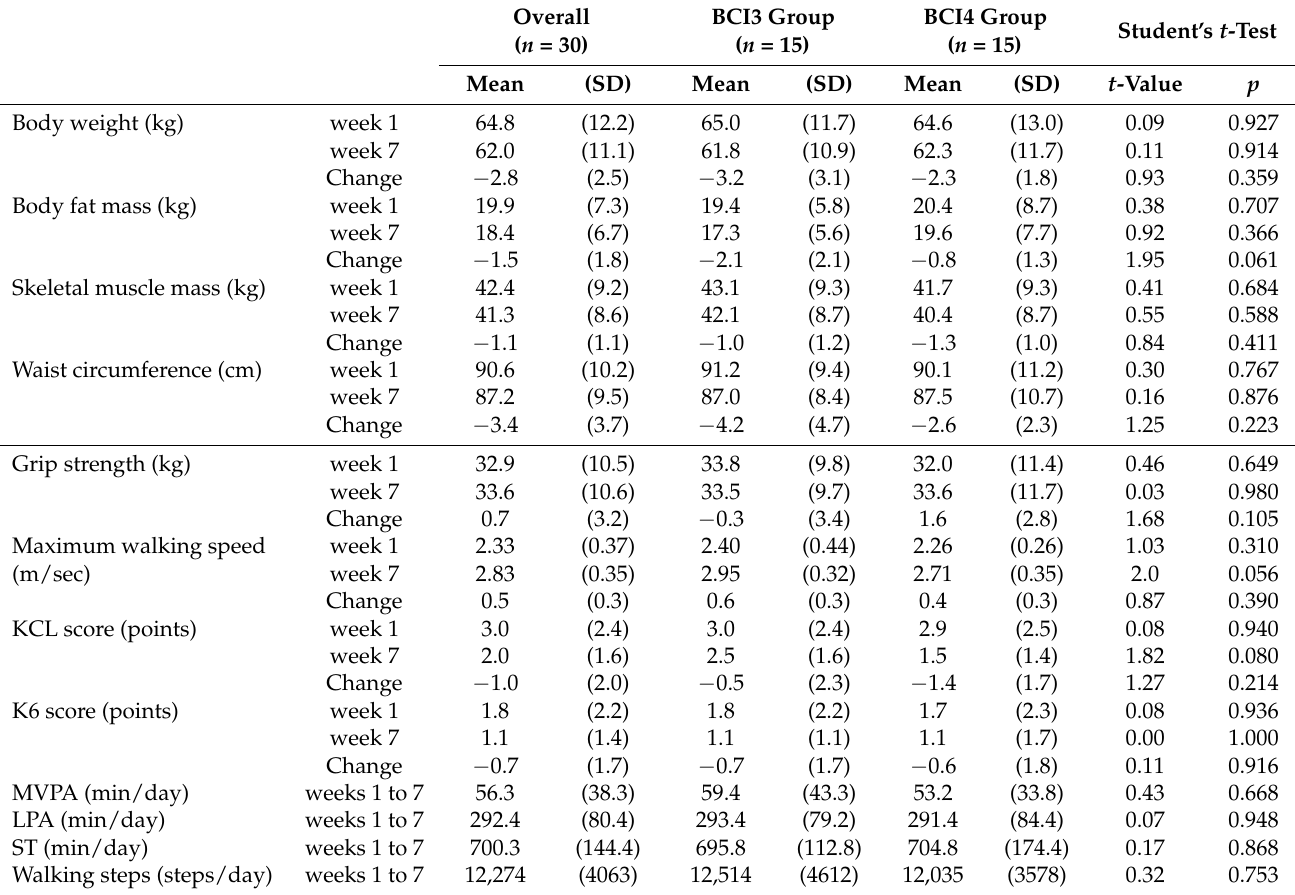
Table 1. Baseline characteristics between BCI3 and BCI4